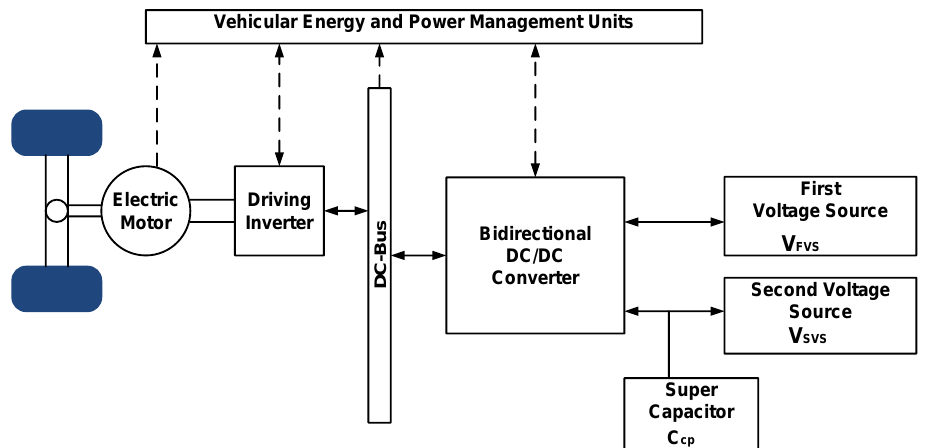
Figure 1. Basic block diagram for a hybrid electric vehicle (HEV) power system.